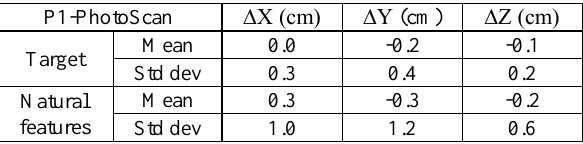
Table 5. Mean and standard deviation of CPs for model P1-PS (SCS).